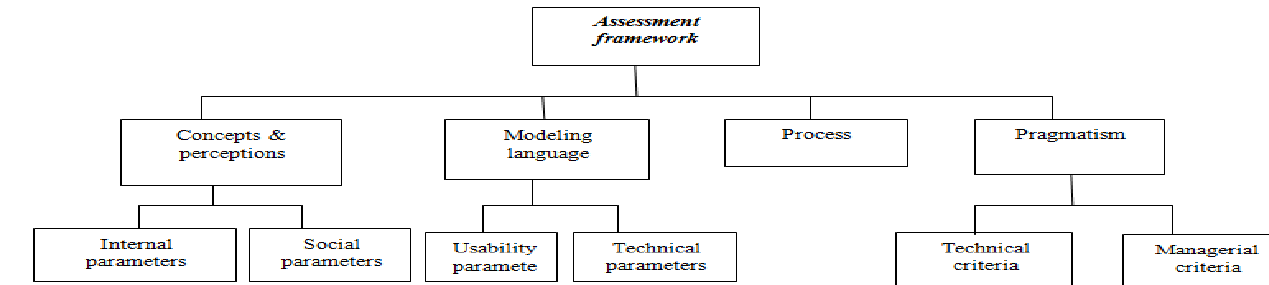
Figure1. General framework of agent oriented methodologies